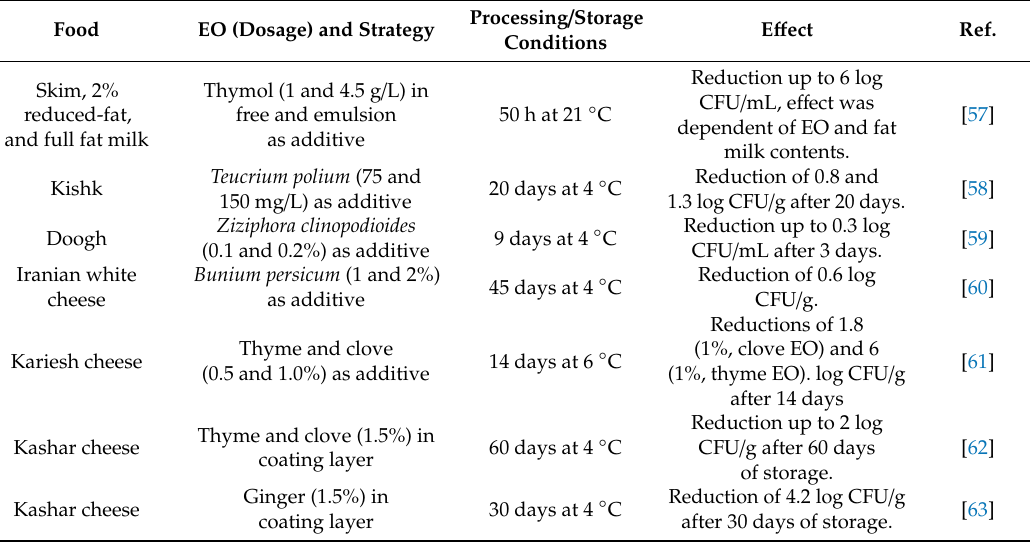
Table 4. Influence of essential oils on pathogenic E. coli in milk and dairy